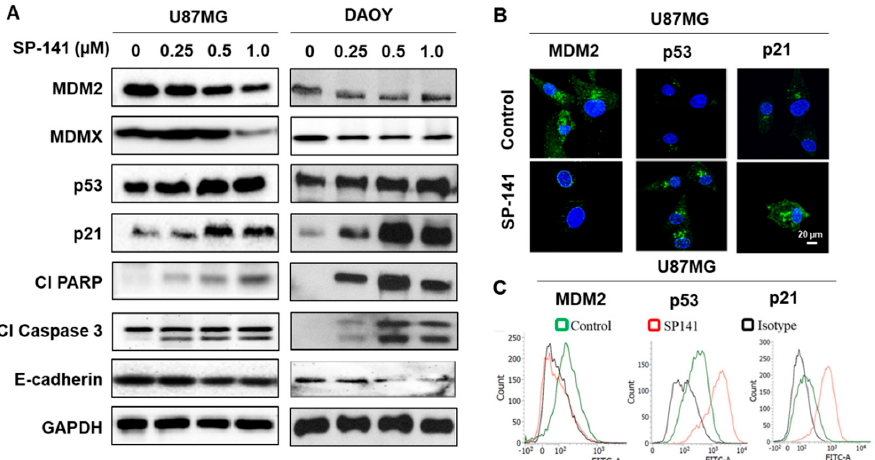
Figure 2. SP-141 downregulates MDM2 in p53 wt and p53 mutant brain tumor cell lines. ( A ) Brain tumor cells were treated with various concentrations of SP-141 for 24 h, then immunoblotting was performed to detect the levels of MDM2 and related proteins. GAPDH served as a loading control. ( B ) Immunofluorescence staining showing the expression of p53, MDM2, and p21 in SP-141-treated (0.5 µM for 12h) and untreated cells analyzed using specific p53, MDM2, and p21 antibodies. Scale bars: 20 µm. ( C ) Flow cytometric analysis of SP-141-treated (0.5 µM for 12h) U87MG cells using specific MDM2, p53, and p21 antibodies along with their isotype antibodies (IgG 1 , IgG 2a, and IgG, respectively) as isotype controls.